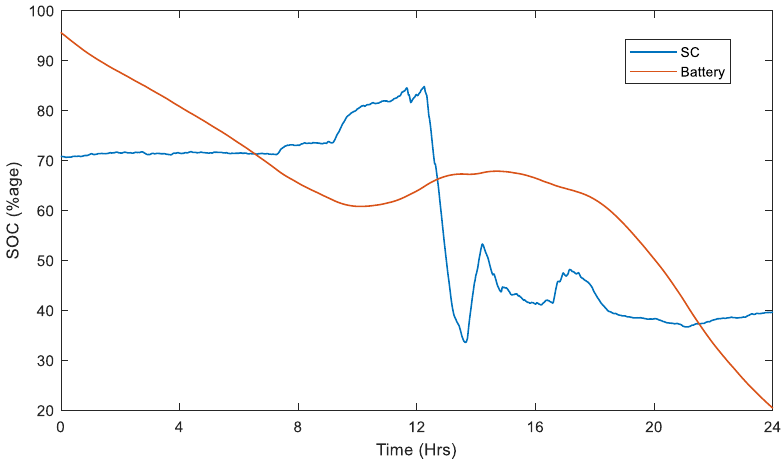
Figure 12. Operating states.